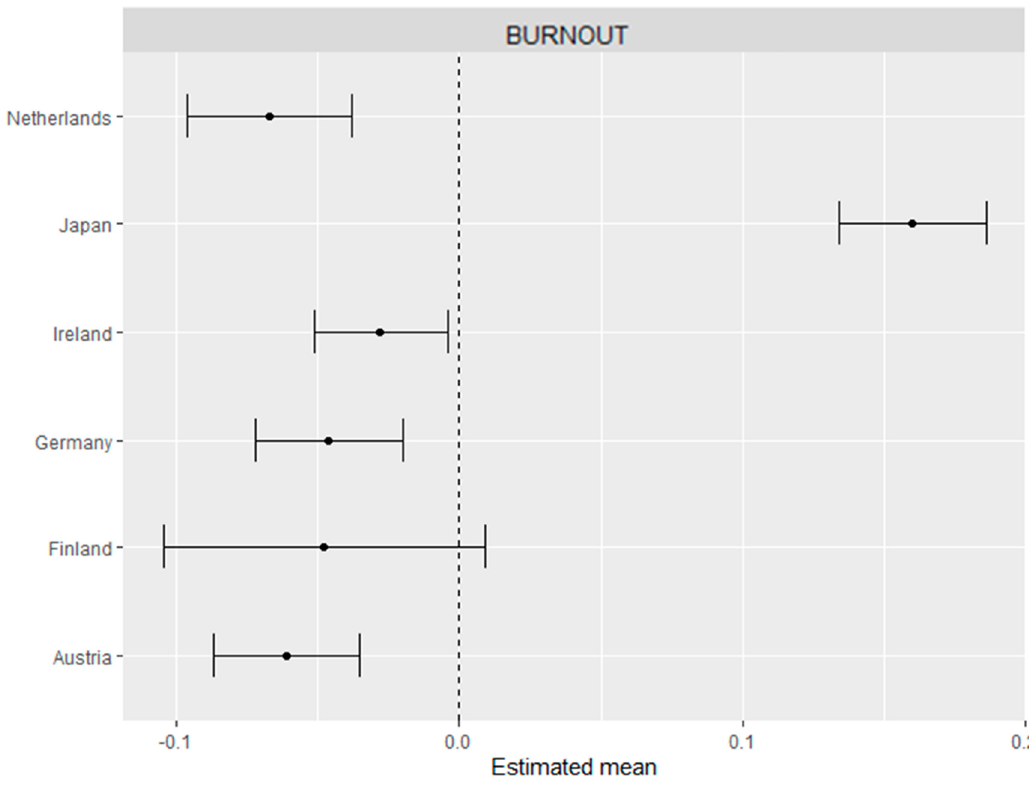
Figure2. E ff Figure 2. Effect sizes with 95% CIs for the second-order burnout factor with Belgium as a reference group.